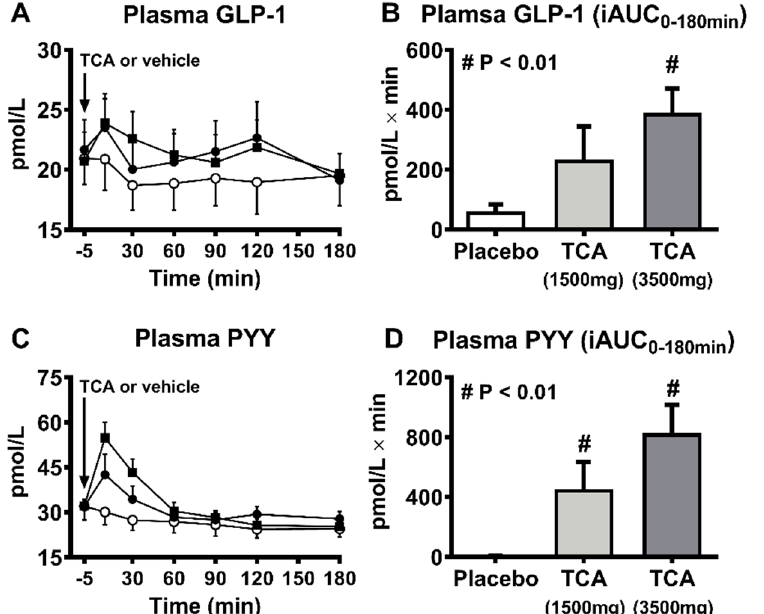
Figure 2. Plasma glucagon-like peptide-1 (GLP-1) ( A , B ), and peptide YY (PYY) ( C , D ) (means ± sem.) after rectal taurocholic acid (TCA) enema in 10 healthy humans. ( B ) p = 0.019 for incremental area under the curves (iAUC); r = 0.48, p = 0.004 for dose-dependent effect; (D) p = 0.0005 for iAUC; r = 0.56, p = 0.001 for dose-dependent effect. Reproduced with permission from [42] © (2013).